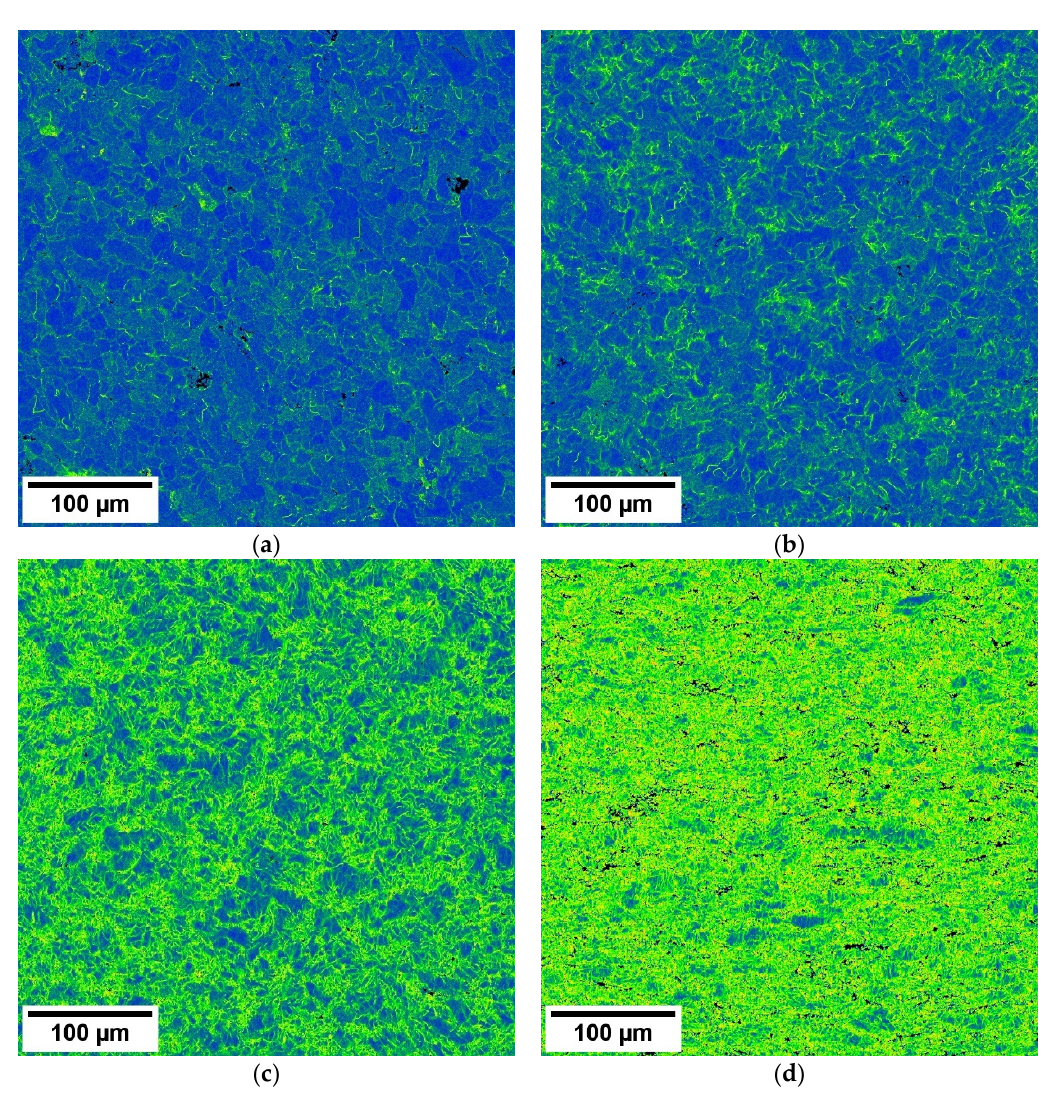
Figure 6. Kernel average misorientation (KAM) maps calculated from EBSD data. ( a ) ε = 2.5%, ( b ) ε = 15%, ( c ) ε = 30%, and ( d ) ε = 40% samples.